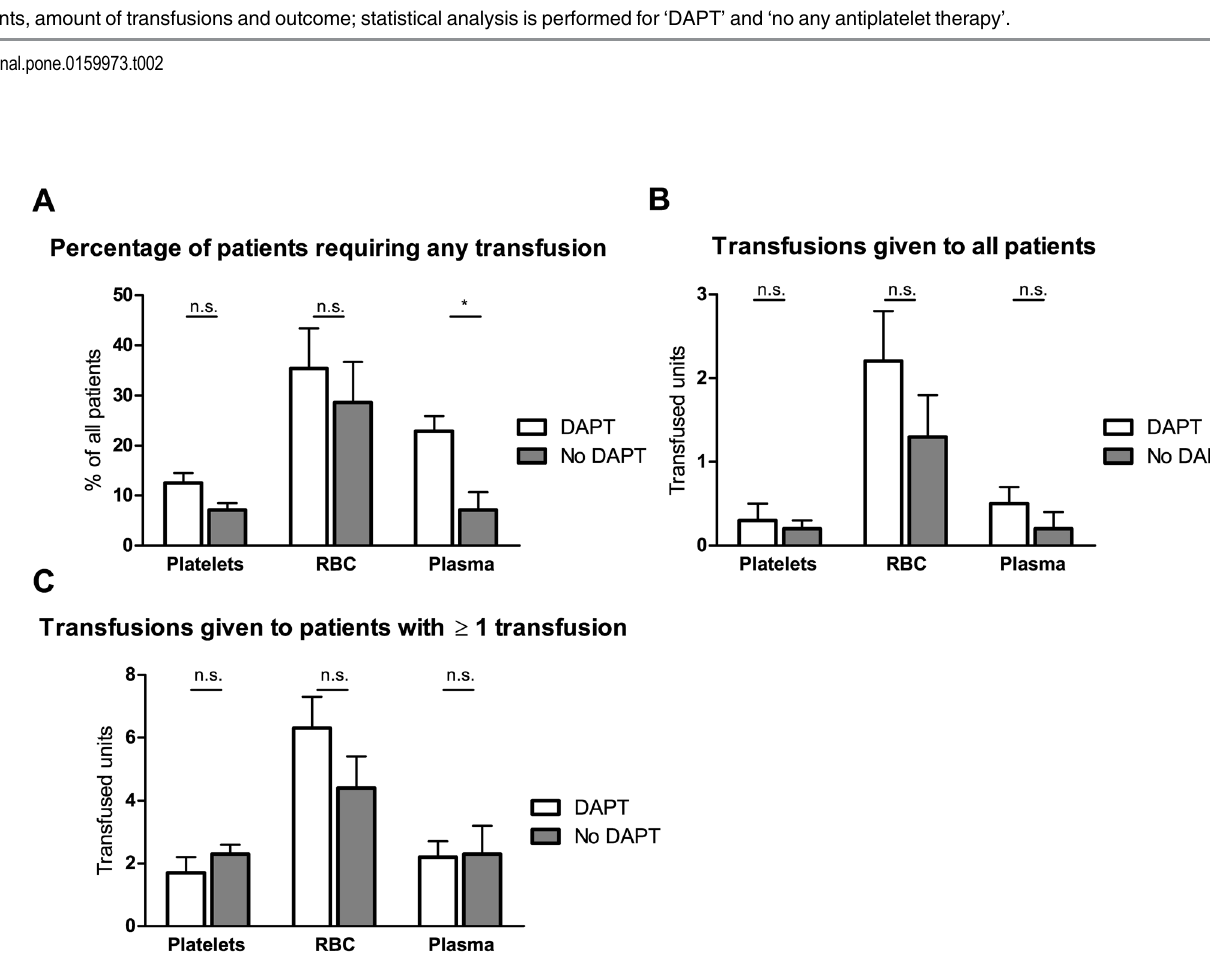
Fig 2. Transfusions of platelets, red blood cells and fresh frozen plasma; Percentage of patients requiring any transfusion (A), Average number of transfused blood products in all patients (B), Average number of transfused blood products in patients receiving at least one transfusion